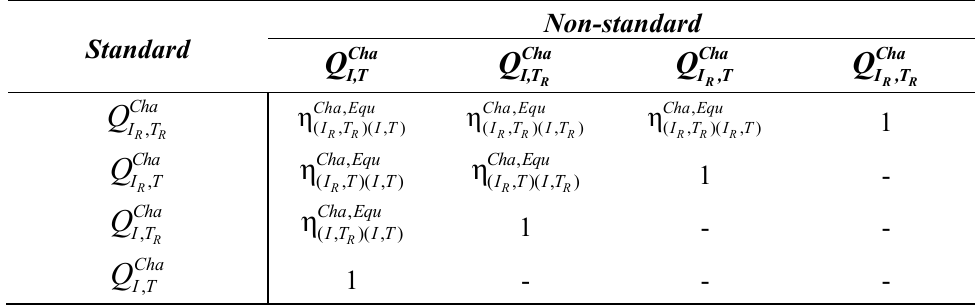
Table 4. Equivalent charge coulombic efficiency at different conditions.